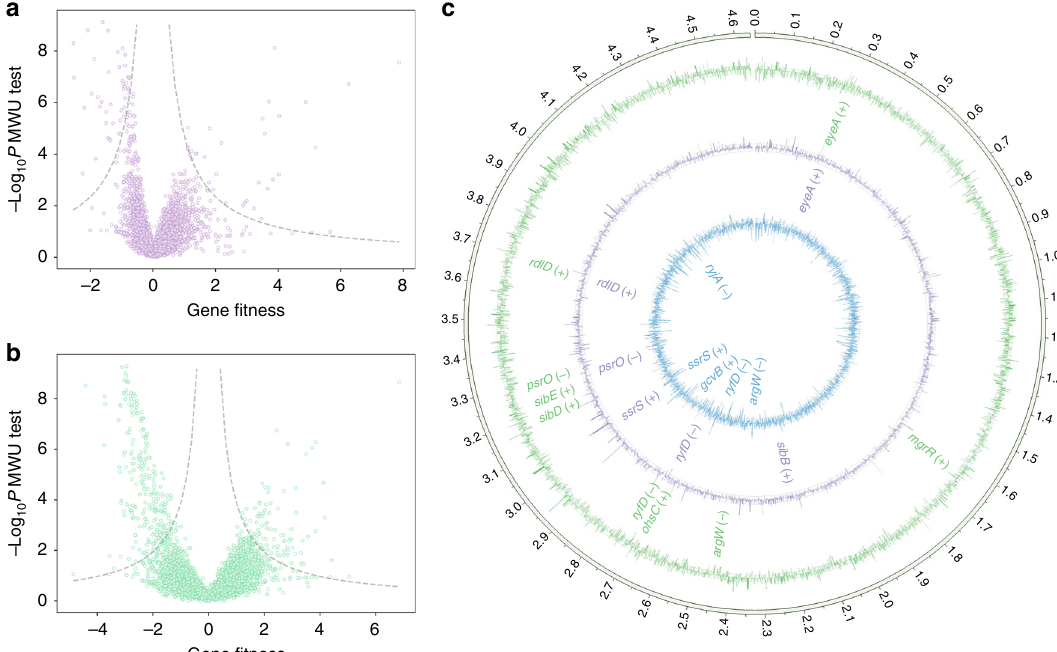
Fig. 6 Genes conferring tolerance phenotypes with respect to the toxic chemicals isobutanol (purple) and furfural (green). a , b Volcano plot of gene fi tness in MOPS medium supplemented with 4 g/L isobutanol ( a ; FDR = 0.1, dashed line) and 0.4 g/L furfural ( b ; FDR = 0.05, dashed line). c Genomic plots of fi tness for library variants in the presence of furfural (outer, green), isobutanol (middle, purple) and no supplementation (MOPS medium alone; inner, blue). The bars of each circle indicate the fi tness for genes of relevant phenotypes. ncRNAs conferring signi fi cant phenotypes ( ‘ + ’ for tolerance and ‘ − ’ for sensitivity) (FDR < 0.05 or | fi tness|>3 for auxotrophy in MOPS media and furfural tolerance, FDR < 0.1 or | fi tness|>3 for isobutanol tolerance) under these conditions are